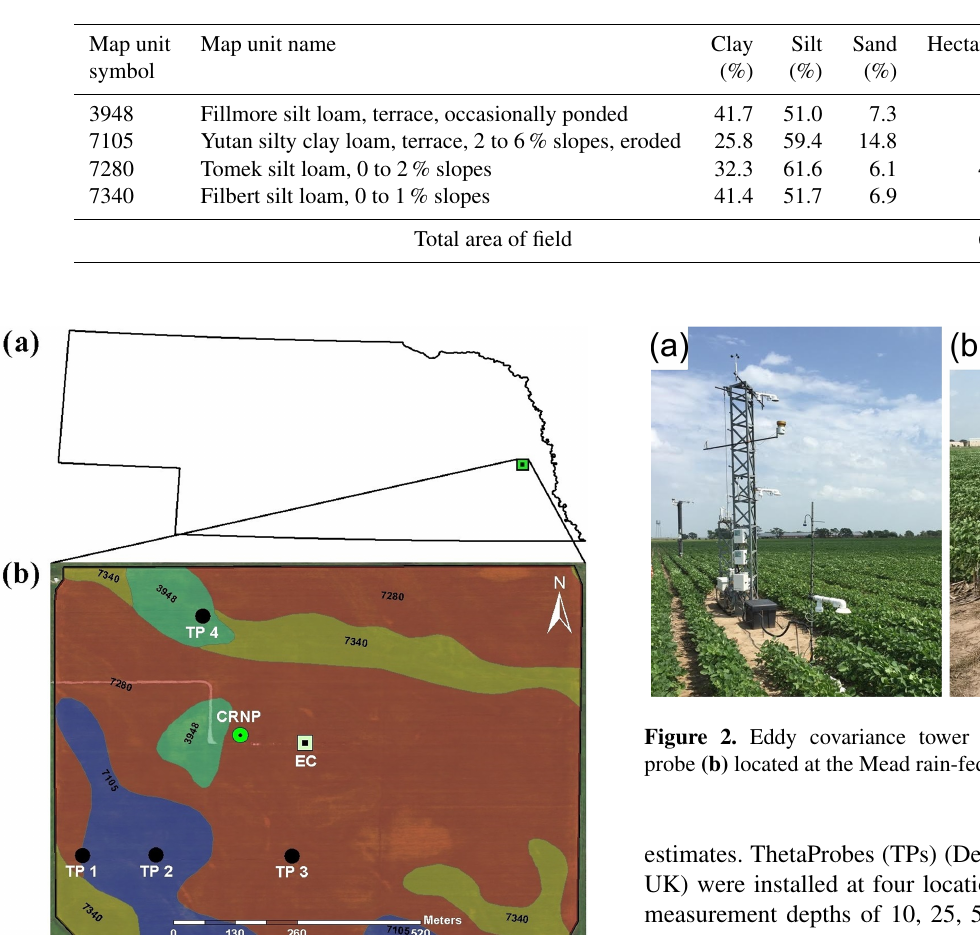
Table 1. Variability of soil texture in the study field based on Web Soil Survey data (http://websoilsurvey.sc.egov.usda.gov/App/HomePage. htm).